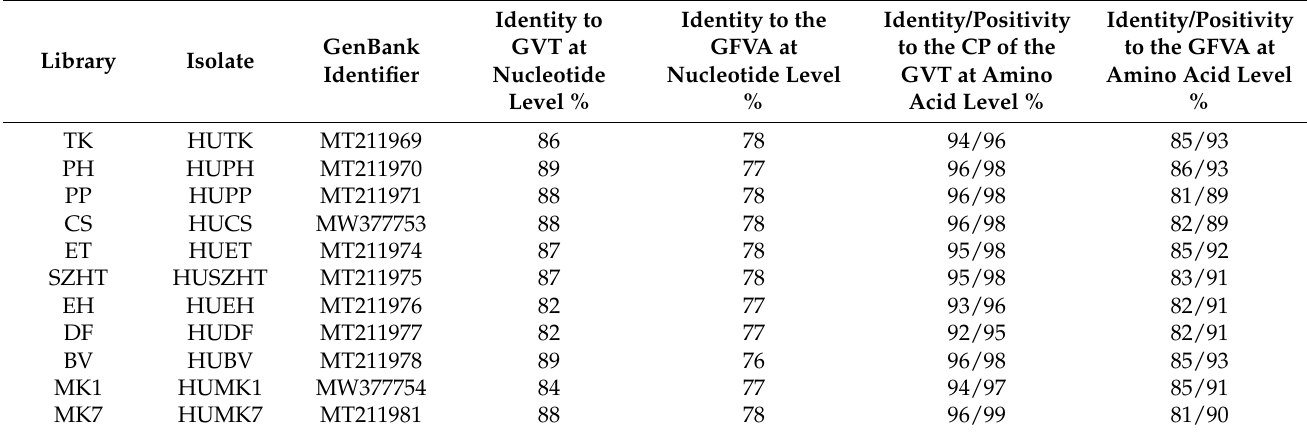
Table 1. GVT sequences, which were deposited into NCBI GenBank, together with their accession number. Nucleotide sequences of the partial sequences were pairwise compared by BLASTn algorithm to both the GVT reference genome (Supplementary Material S1) and the GFVA sequence (MN553040). This pairwise comparison was done by BLASTp for the CP coding part of the partial sequences, and for calculating the identity and positivity in the amino acid